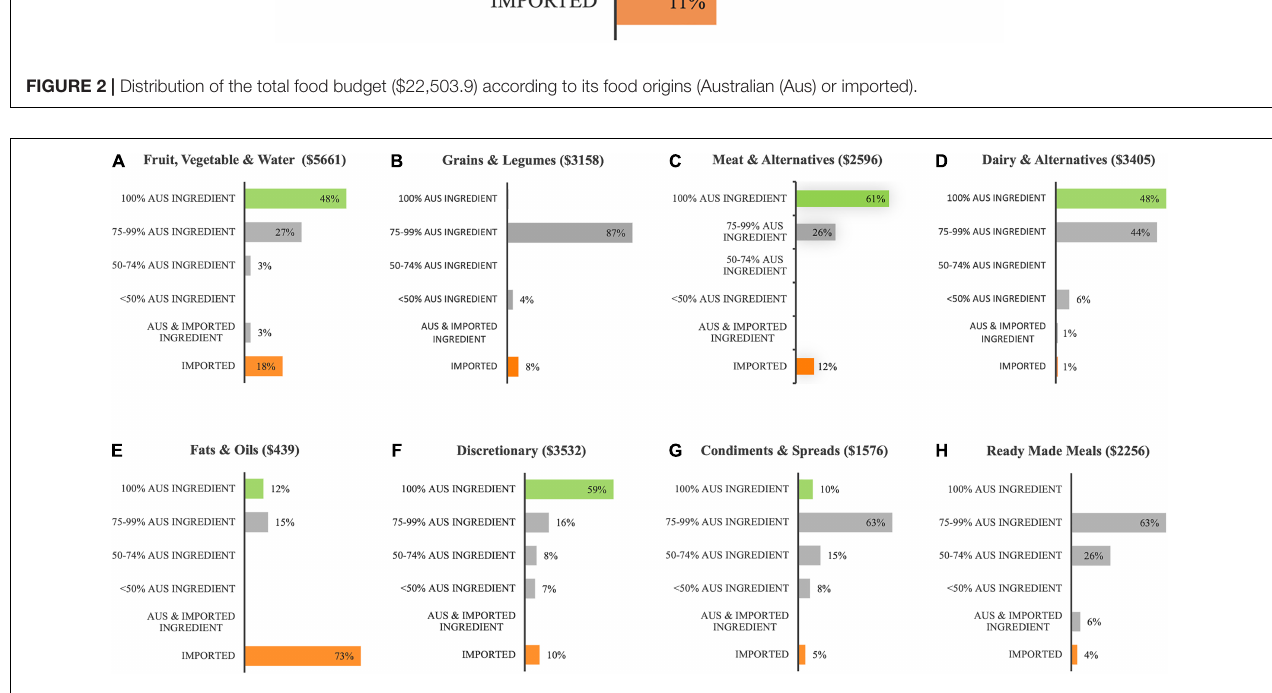
FIGURE 3 | Distribution of the total food budget across eight food group categories (A–H) , according to its food origins [Australian (Aus) or imported].